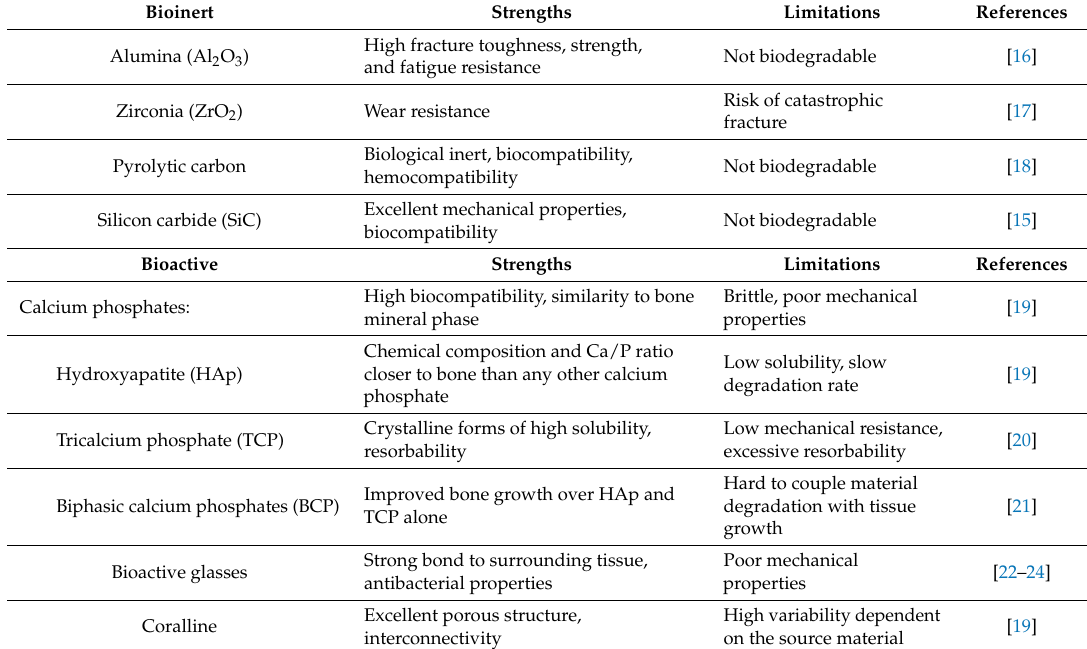
Table 1. General classification of the main bioceramics used in the tissue engineering field based on their biological